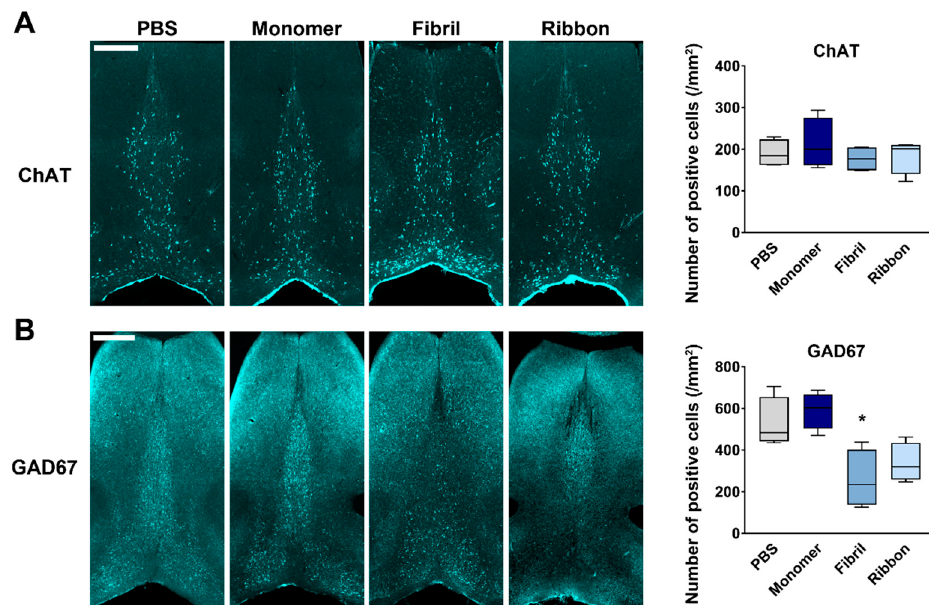
Figure 3. Selective decrease in septal GABAergic neurons after intrastriatal injection of α Syn. ( Left ) Representative images of choline acetyltransferase (ChAT)-positive ( A ) and glutamic acid decarboxylase 67 (GAD67)-positive ( B ) cells in the medial septum/diagonal band (MS/DB), 30 days after the injection. Scale bar: 500 µ m. ( Right ) Quantitative analyses of each protein-positive cell number in the MS/DB. * p < 0.05 vs. PBS-injected group ( n = 4 per group).